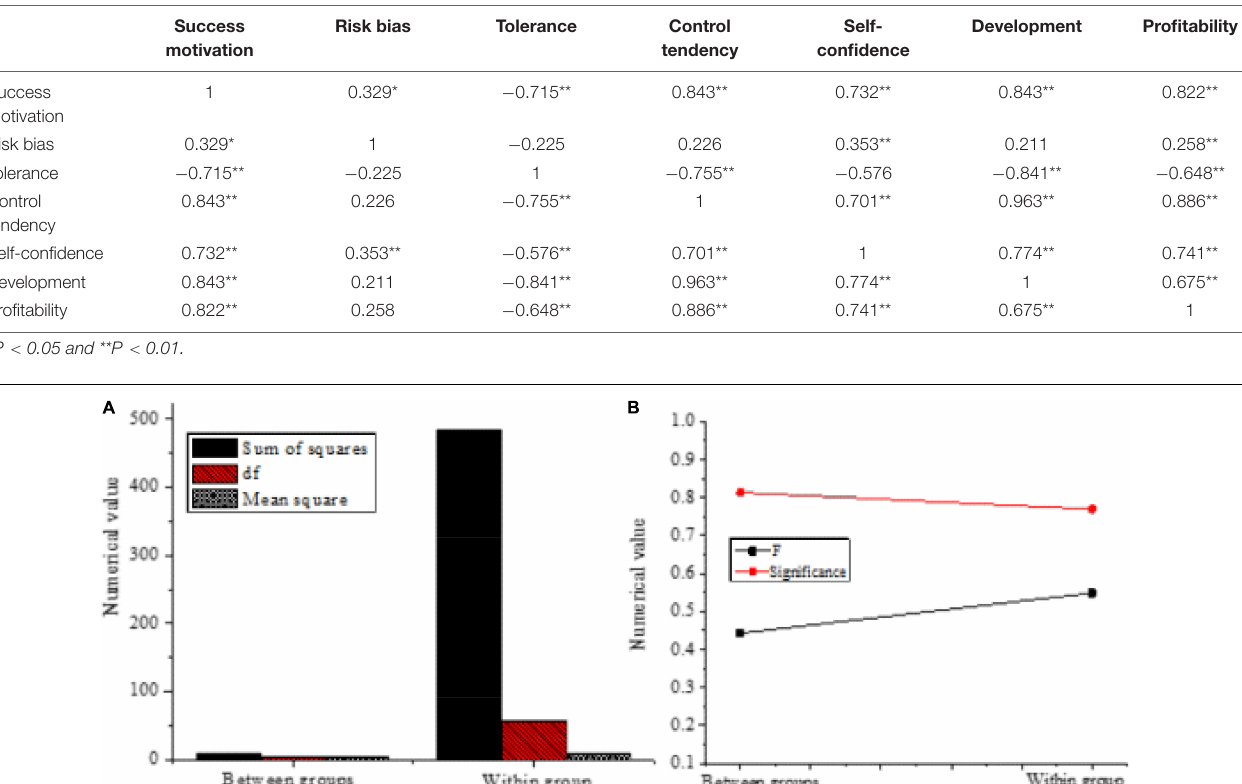
TABLE 5 | Pearson’s correlation coefficient of psychological characteristics and entrepreneurial performance.